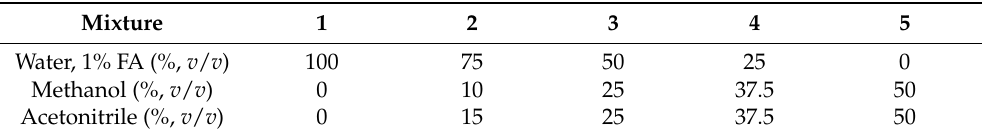
Table 1. Composition of different extraction mixtures containing various proportions of 3